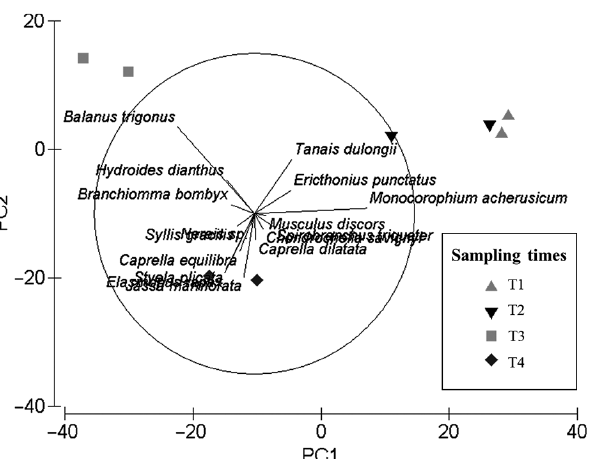
Fig. 7. Principal component analysis performed on square root transformed data of 16 most abundant macrofaunal spe- cies during the 4 sampling time periods (see Fig. 1). The first 2 axes explained 86.6% of the